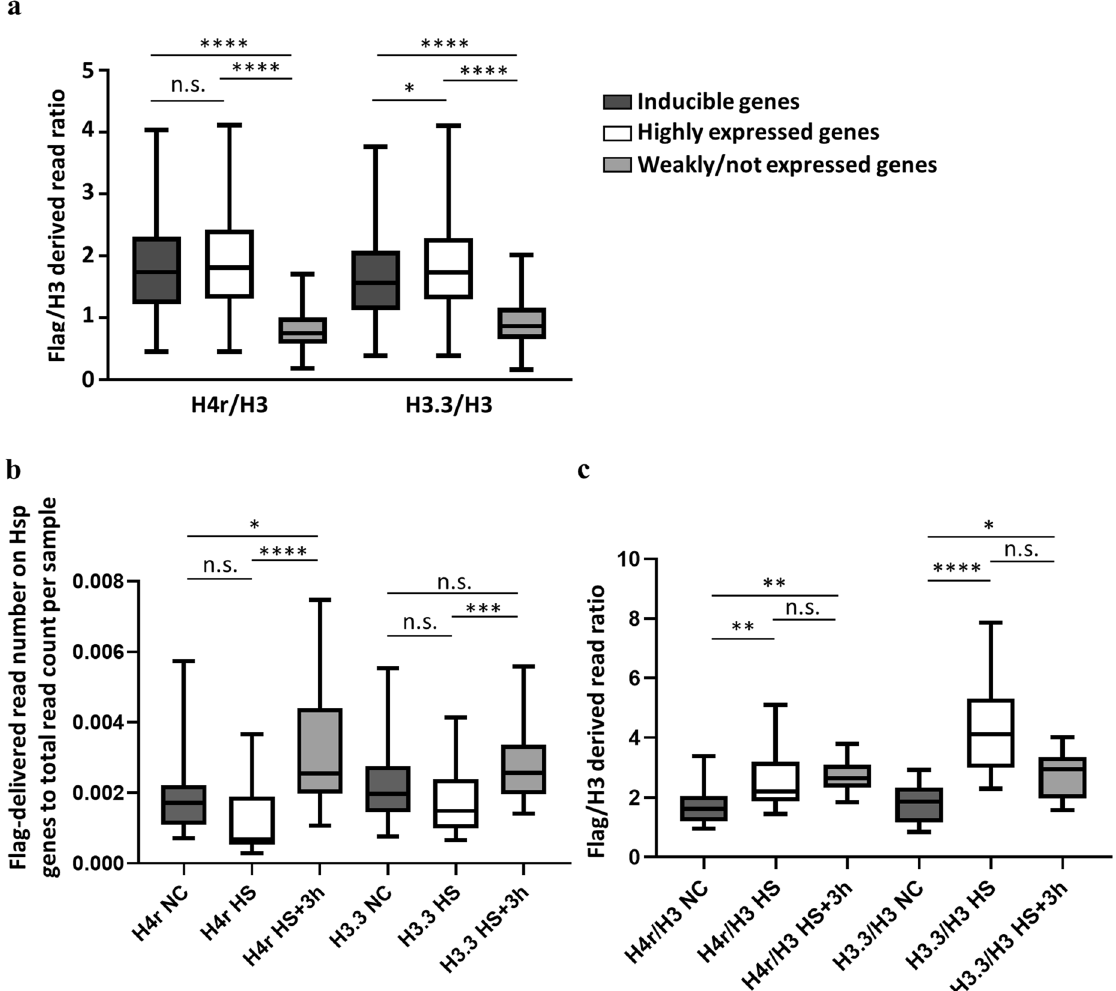
Figure 6. H4r and H3.3 nucleosomal distribution on inducible genes. ( a ) Amount of alternative histones relative to canonical H3 on genes that are inducible (n = 972), expressed highly (n = 323), or weakly/not (n = 2846) in the adult head (expressional data derives from FlyBase). Statistical analysis method used: Kruskal– Wallis test. ( b ) Changes in the ratio of reads on Hsp genes relative to the total read count of the given sample (n = 13) Statistical analysis method used: Friedman-test. ( c ) Changes in the alternative/canonical histone ratio (n = 13). Statistical analysis method used: Friedman-test. n.s.: not significant; *: p < 0.05; **: p < 0.01; ***: p < 0.001; ****: p < 0.0001. Error bars represent